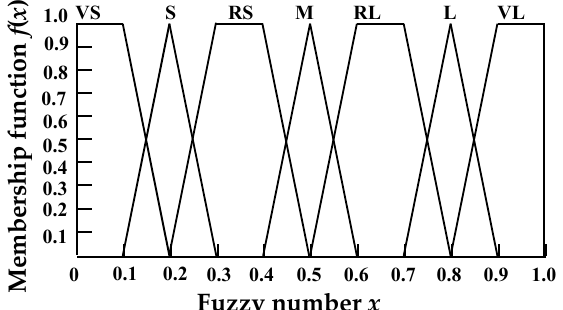
Figure 4. Fuzzy numbers represent linguistic value. 247